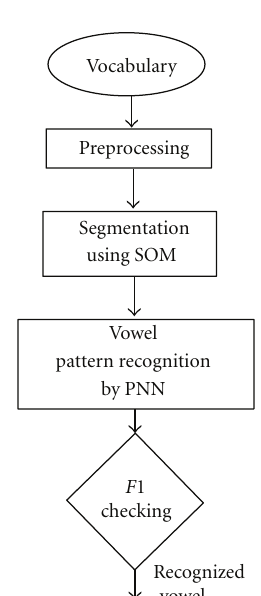
of PNN2 are /e/ and /o/, and so forth. These four PNNs are used sequentially to identify the segmented vowel